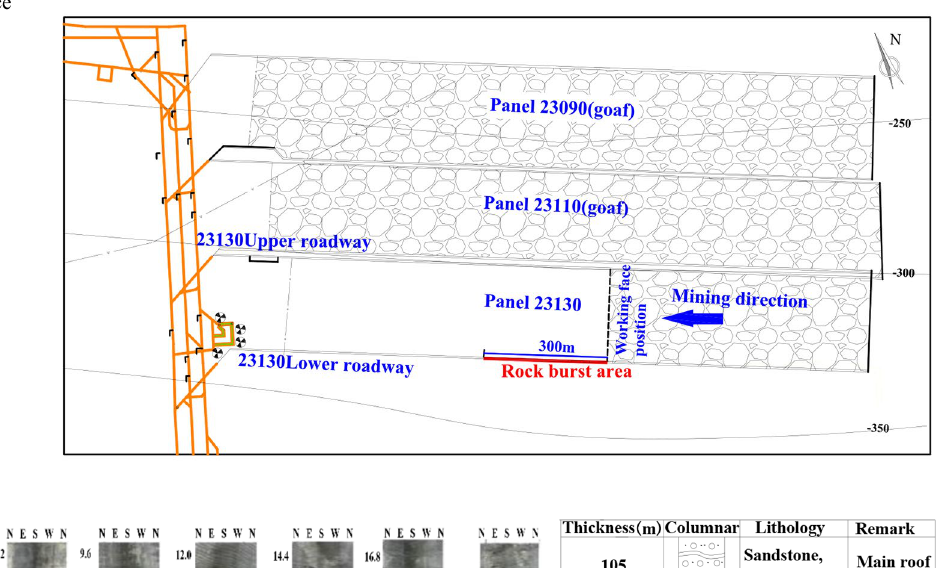
Fig. 1 Layout of the working